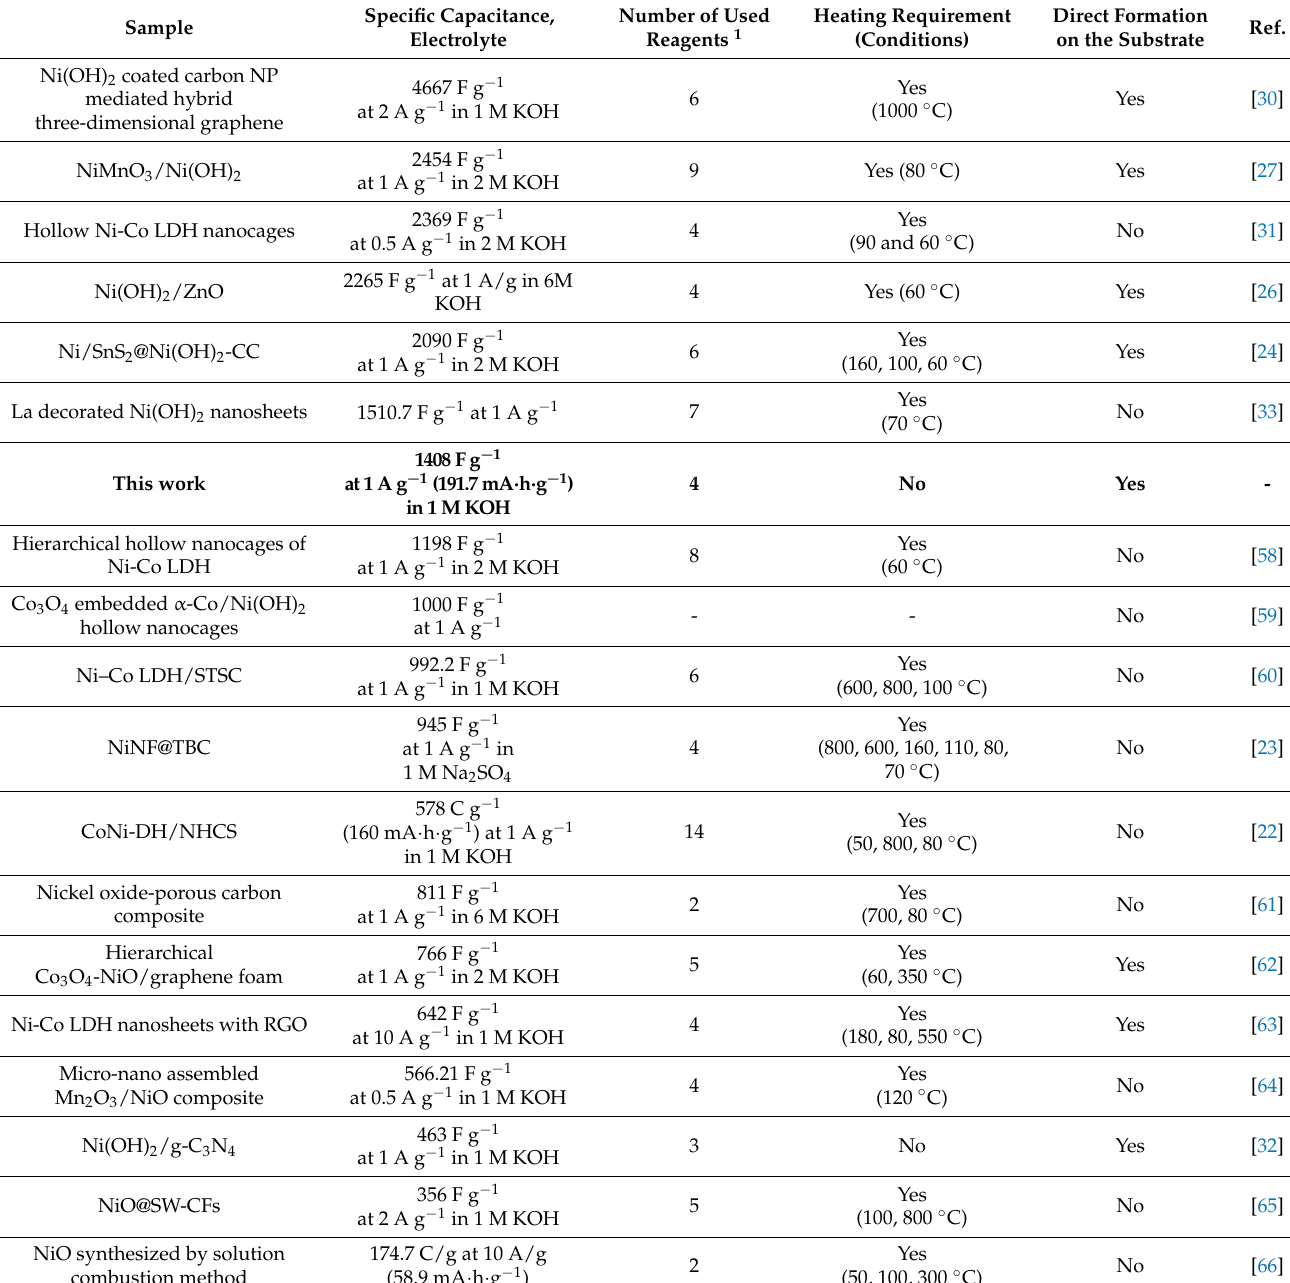
Table 1. Comparison of the synthesis methods in the framework of their complexity and primary cost. Capacitances, the number of the used reactants and the heating requirements for the proposed and other synthesis methods are